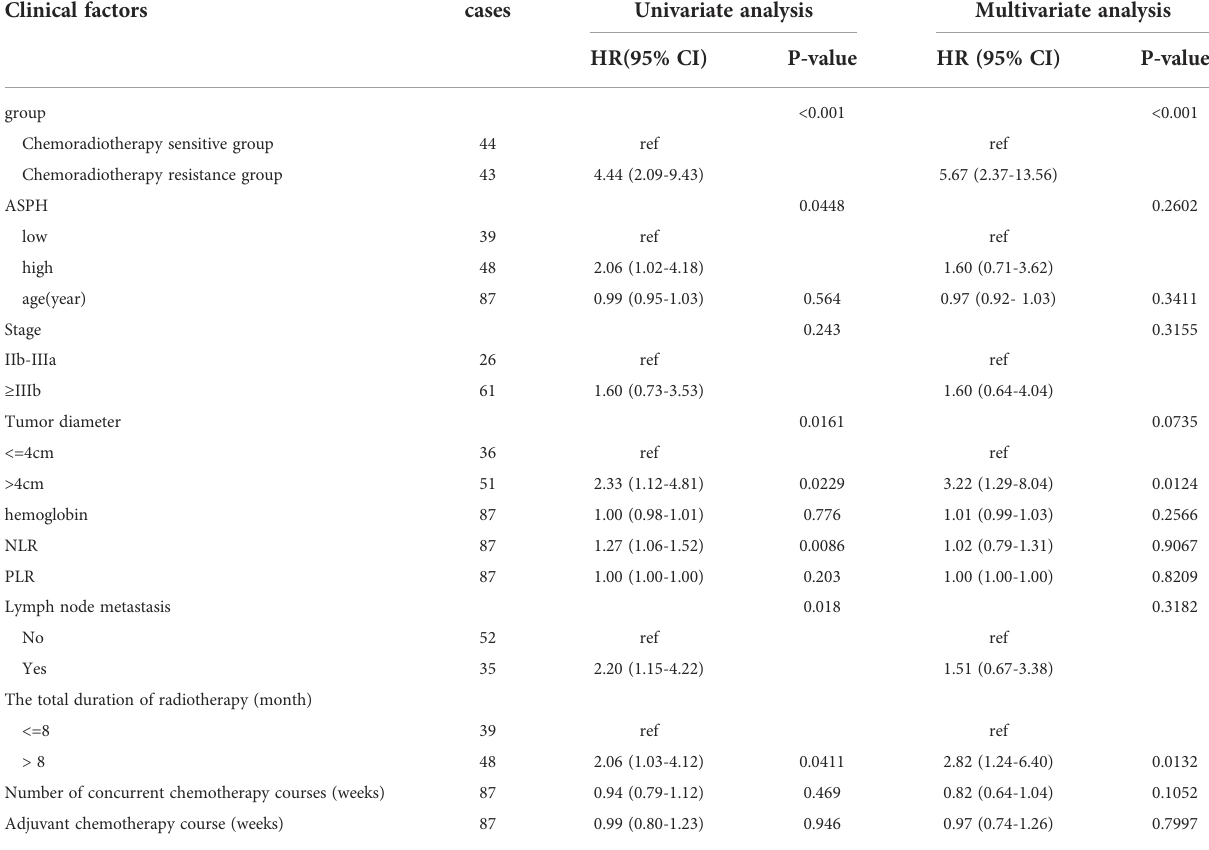
TABLE 4 Analysis of clinical factors affecting OS of radiotherapy and chemotherapy for intermediate and advanced cervical squamous cell carcinoma. Clinical